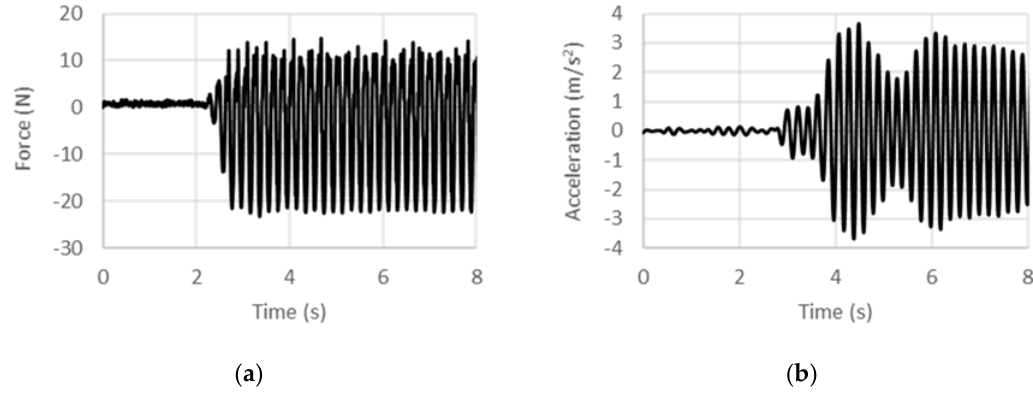
Figure 15. Experimental ( a ) force and ( b ) acceleration histories at 5 Hz under acceleration control.